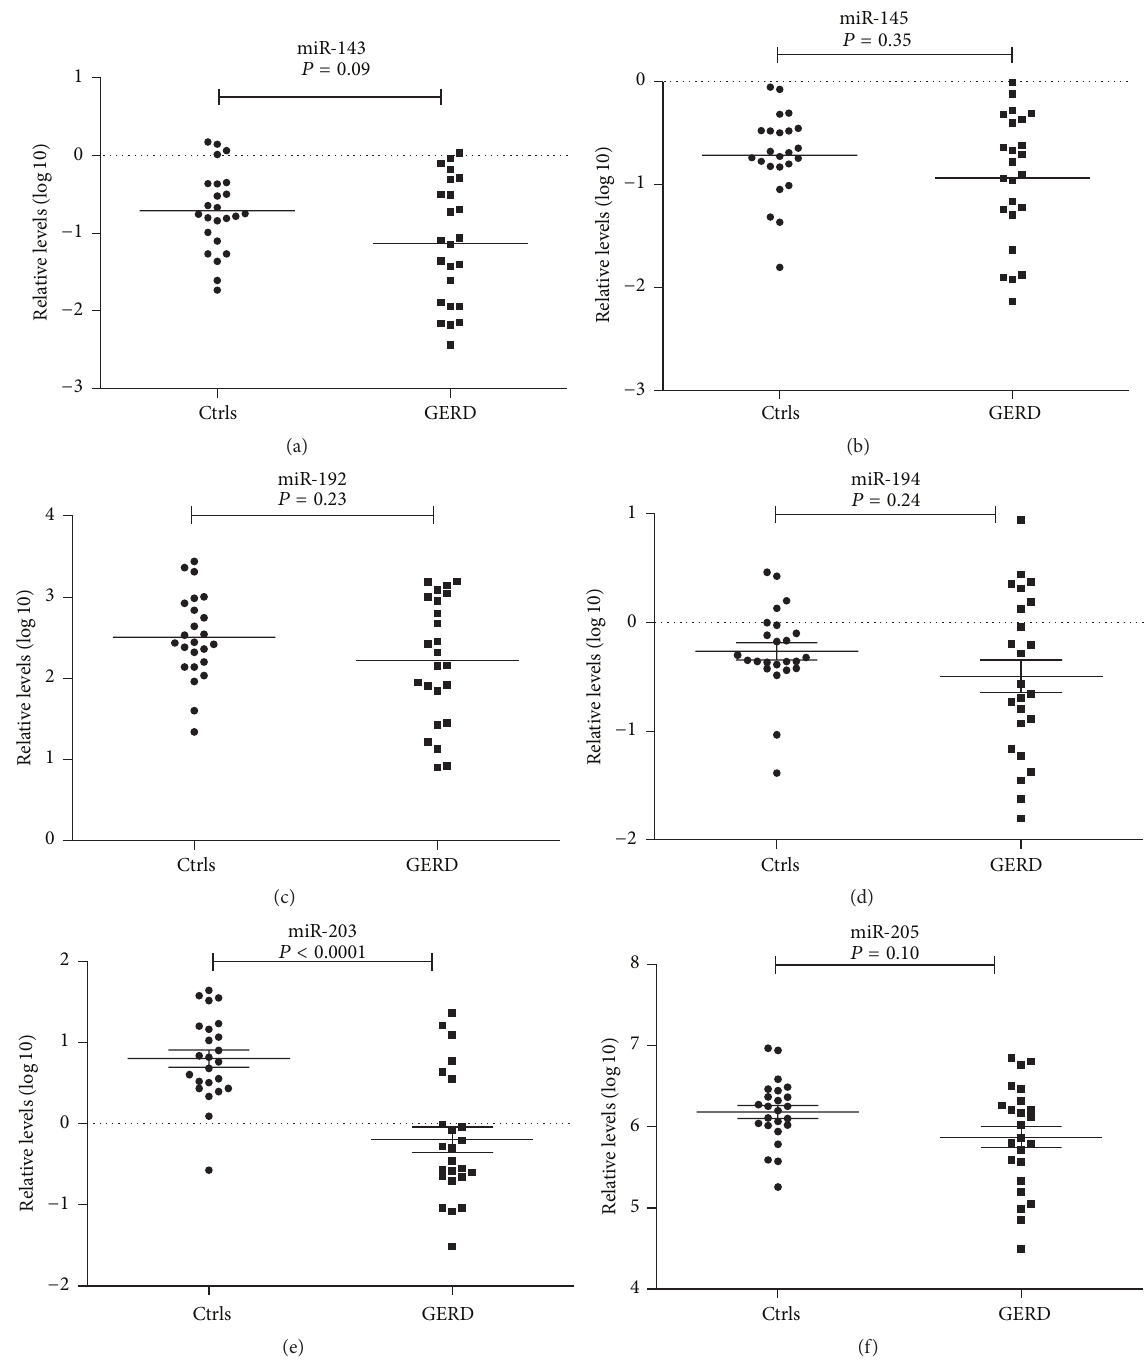
Figure 1: miRNA expression profile in exfoliated cells of the tongue in GERD and Ctrls. qRT-PCR expression levels of miR-143 (a), miR-145 (b), miR-192 (c), miR-194 (d), miR-203 (e), and miR-205 (f) in patients with GERD ( 𝑛 = 24 ) and healthy donors (Ctrls, 𝑛 = 24 ). The median level of expression is represented in each group by a solid line. The values are normalized to U6 expression levels and displayed in log 10 scale on 𝑌